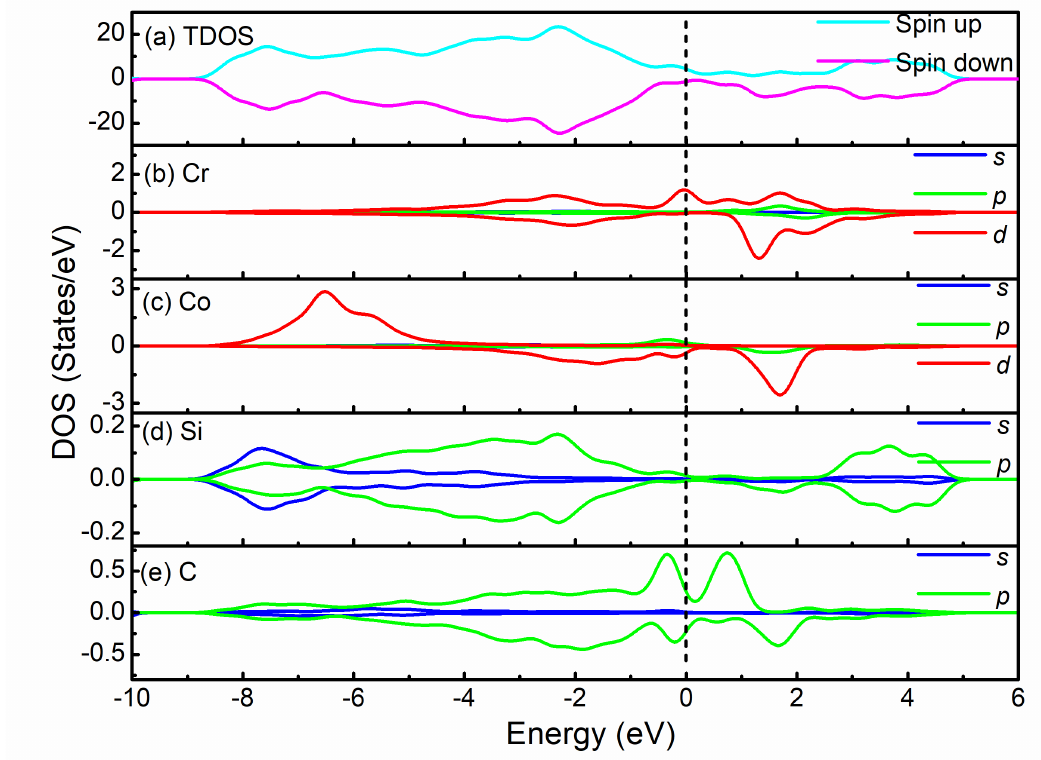
Figure 6. ( a – e ) Total and partial density of states of (0, 10) configuration (Cr, Co, V Si )-codoped 4H–SiC. The Fermi level is set to 0